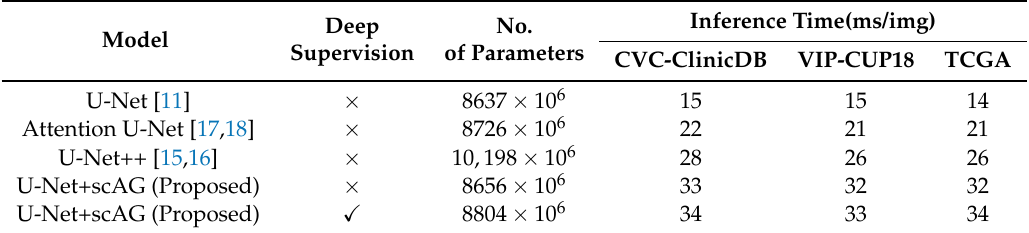
Table 5. Comparison of latency of testing consumption on three